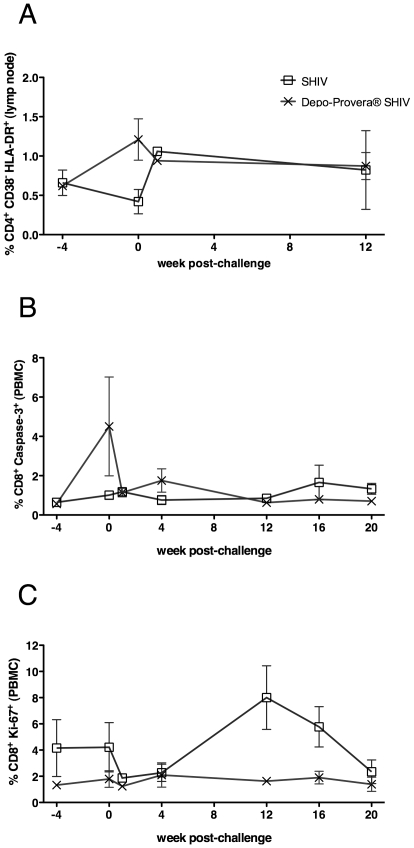
Frequencies of activated T cells after progesterone treatment and IV SIVmac239 challenge.A) Percent of CD3+ CD4+ T cells expressing CD38 but not HLA-DR in PBMC. B) Percent of CD3+ CD8+ T cells expressing CD38 but not HLA-DR in PBMC. D) Percent of CD3+ CD8+ T cells expressing Ki-67+ in PBMC. E) Percent of CD3+ CD8+ T cells expressing caspase-3+ in PBMC. (○) SHIV-immunized macaques (n = 5) and (5) Depo-Provera®-treated, SHIV-immunized (n = 6).